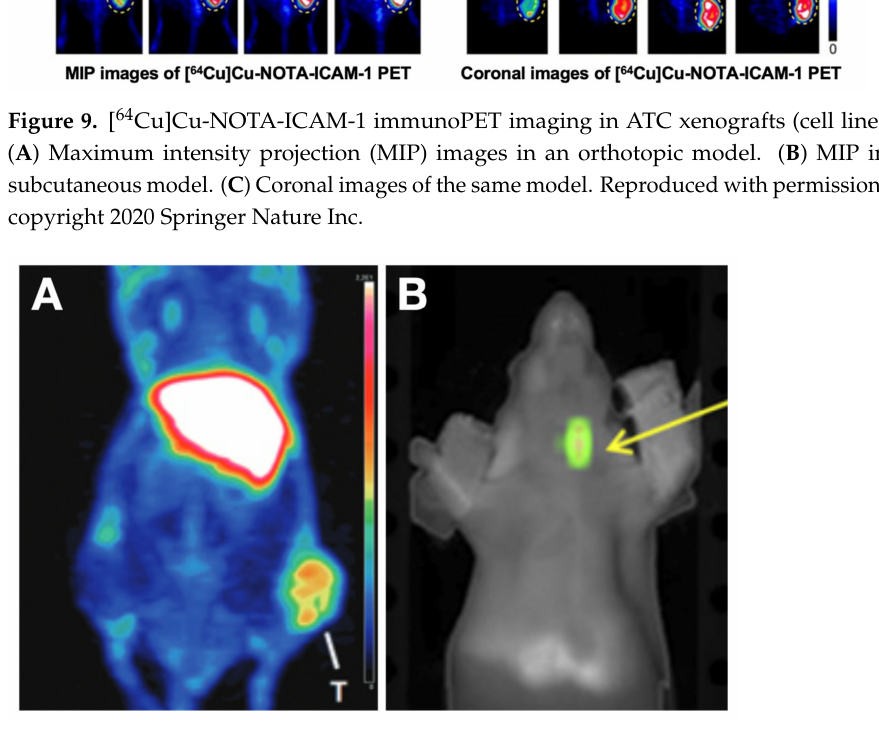
Figure 10. Characterization of [ 89 Zr]Zr-Gal-3 in TC xenografts. ( A ) PET image acquired at 48 h post radiotracer injection in a subcutaneous TC model showed an apparent accumulation of [ 89 Zr]Zr-Gal-3 in a tumor at the right thigh; Reproduced with permission from copyright 2016 American Association for Cancer Research [124]. ( B ) TC in an orthotopic model was visualized after injection of Cy5.5-Gal-3 with fluorescence imaging in the neck. Reproduced with permission from [125] copyright 2019 Society of Nuclear Medicine and Molecular